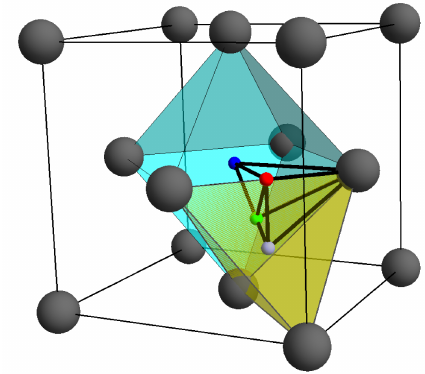
Figure 6. The ideal FCC geometry will be characterized by regular octahedra (turquoise) and tetrahedra (yellow) sharing necessarily flat faces. It is the position of the ring CP that mediates the deviation of an FCC structure from ideality. Transition metals that do not form the FCC structure, when forced, show large deviations from